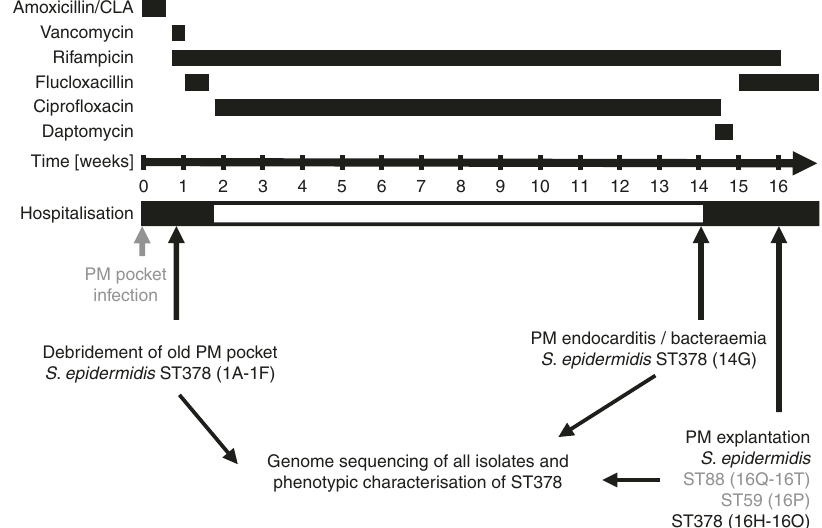
Fig. 1 Overview of the clinical course, treatment, and S. epidermidis sampling. The antibiotic treatment scheme over the 16-week infection period. Surgical interventions and time points of S. epidermidis recovery are indicated. PM Pacemaker, ST sequence